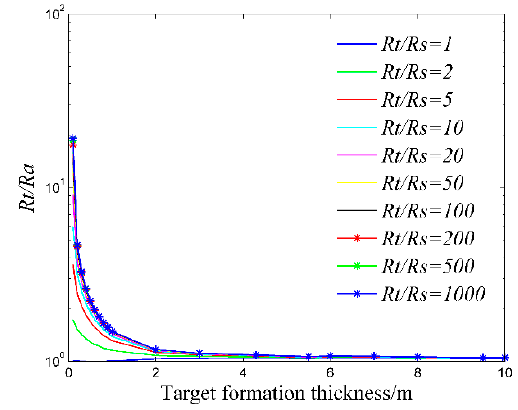
Figure 14. Influence of surrounding rock.